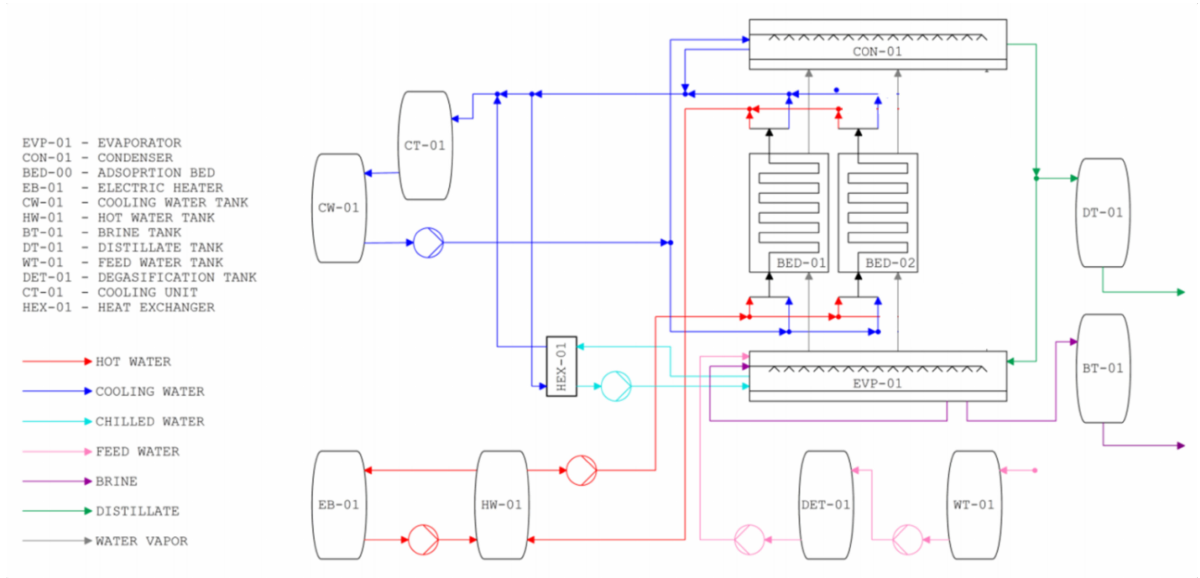
Figure 2. Two-bed adsorption chiller with desalination function. The adsorption chiller with desalination function installed at the Energy Centre of the AGH University of Science and Technology was designed to operate in two modes: Cooling and